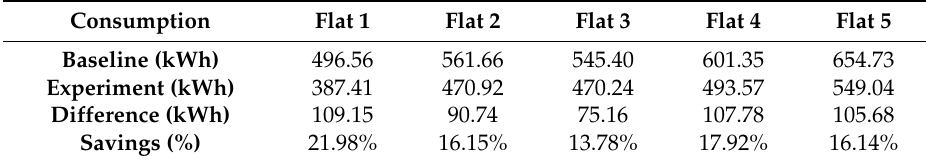
Table 1. Total consumption in kWh during the 30 days of baseline data collection, during the 30 days of the experiment, difference in the consumption and savings between the two